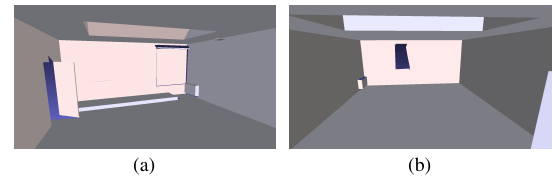
Figure 12. 3D views of generated building model, (a) a first inside view of the room, (b) another view of the scanned scene